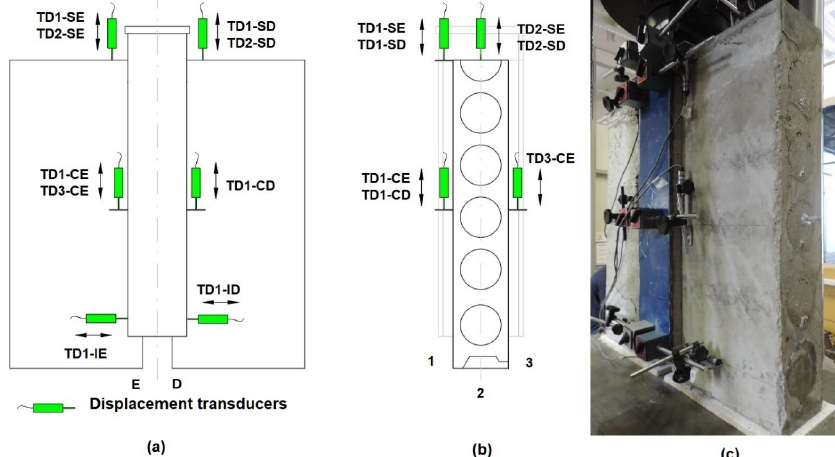
Fig. 7: Test setup and instrumentations of the push-out tests – (a) Frontal view; (b) lateral view; (c) Instrumented